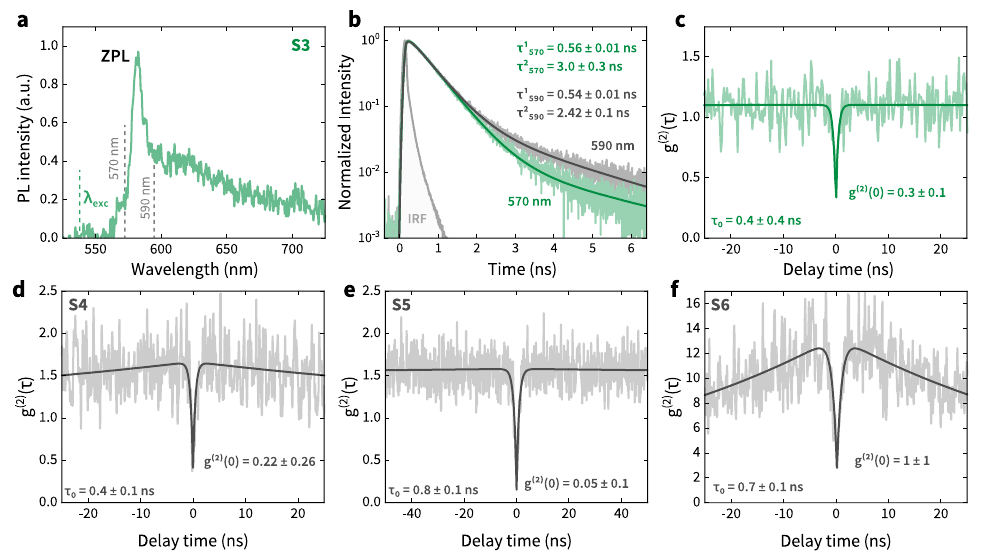
Figure A2. ( a ) The µ -PL spectra of the S3 emitter circled in Figure 2a under 532-nm excitation. The centers of the spectral regions of interest are indicated by dashed lines and have a bandwidth of 20 nm; ( b ) spectrally filtered PL decay curves and fits to the data for S3 at pulsed (80 MHz) 530-nm laser excitation. The light grey curve represents the IRF. Extracted decay times ( τ ) for each curve are presented on the top of the figure; ( c – f ) autocorrelation functions g ( 2 ) ( τ ) for S3 ( c ) and other emitters S4–S6. The absolute g ( 2 ) ( 0 ) values are given with IRF correction.